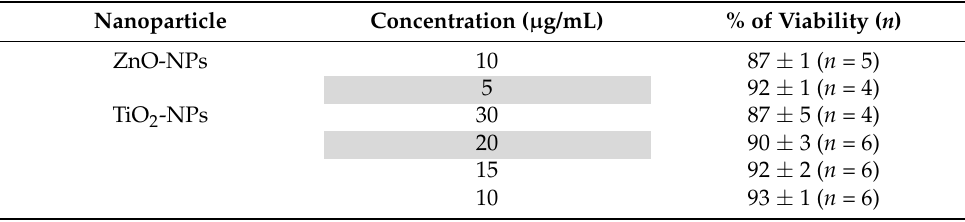
Table 3. Effect of the model NPs on the cell viability of T98G human glioblastoma cells.